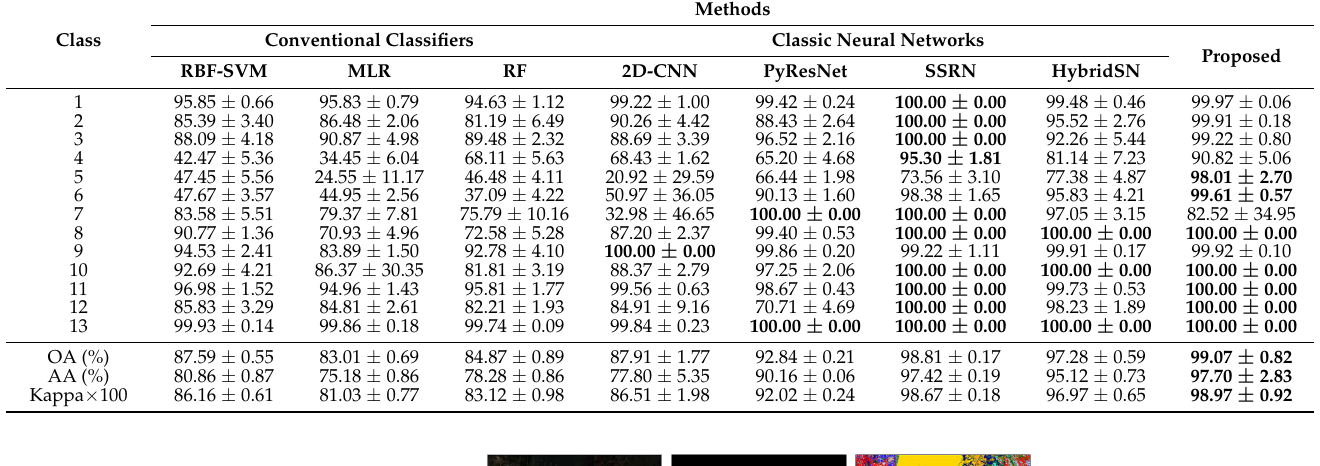
Table 6. The categorized results of different methods on the Paiva of University dataset.